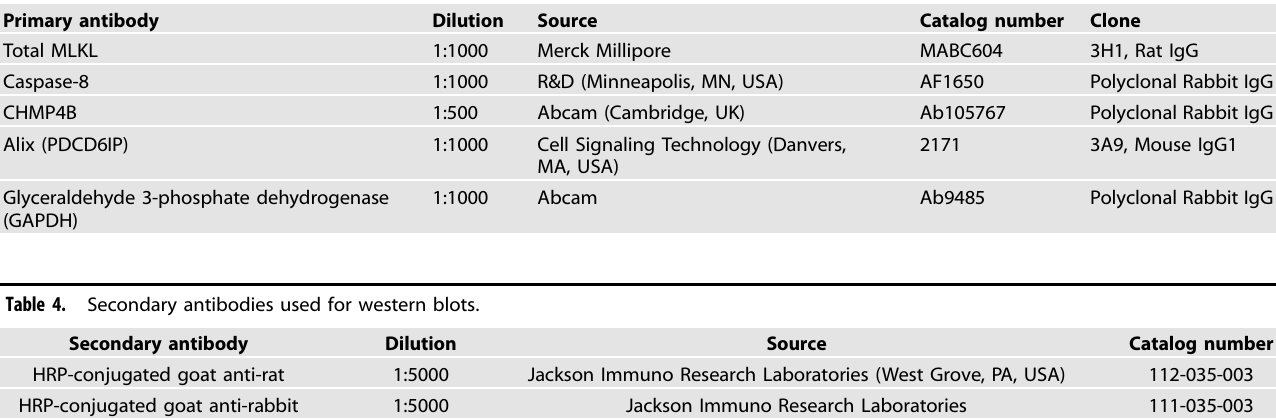
Table 3. Primary antibodies used for western blots.